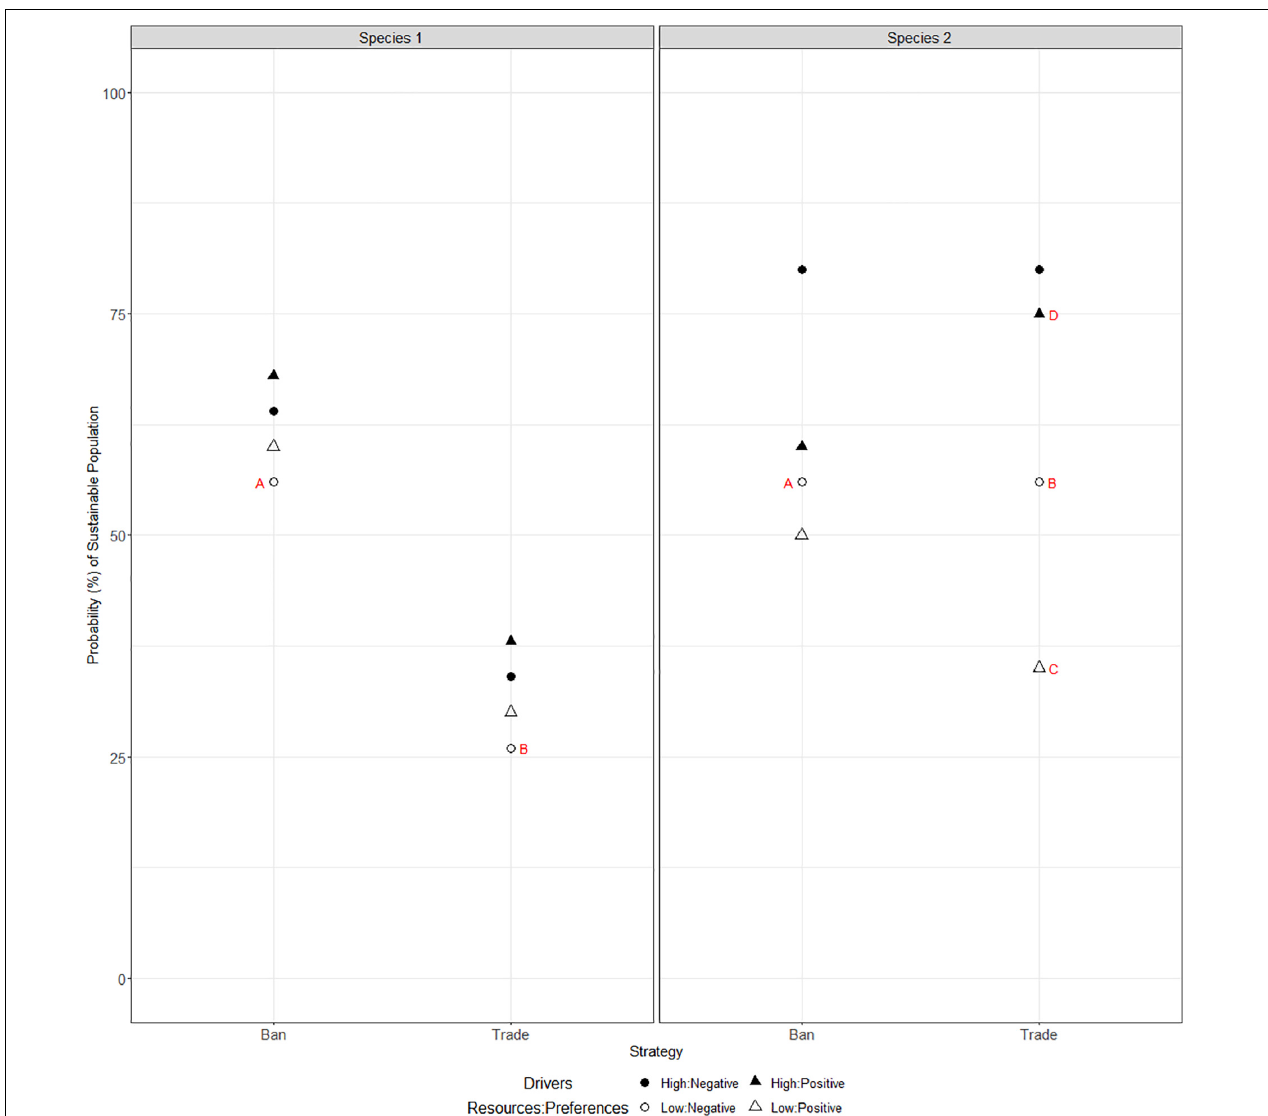
FIGURE 5 | Hypothetical probabilities (as percentage) that two different species are sustainable under two different Strategies ( Ban or Trade ), given different combinations of the drivers: Resource Availability at source sites either High (filled symbol) or Low (empty symbol) and Consumer Preferences are either Negative (circle) or Positive (triangle). The probability that either species is sustainable when Resource Availability is Low and Consumer Preferences are Negative is point A when Strategy is Ban and point B when Strategy is Trade . For species 2, point C shows the probability under Trade when Consumer Preferences are Positive . Under point D Resource Availability is also High